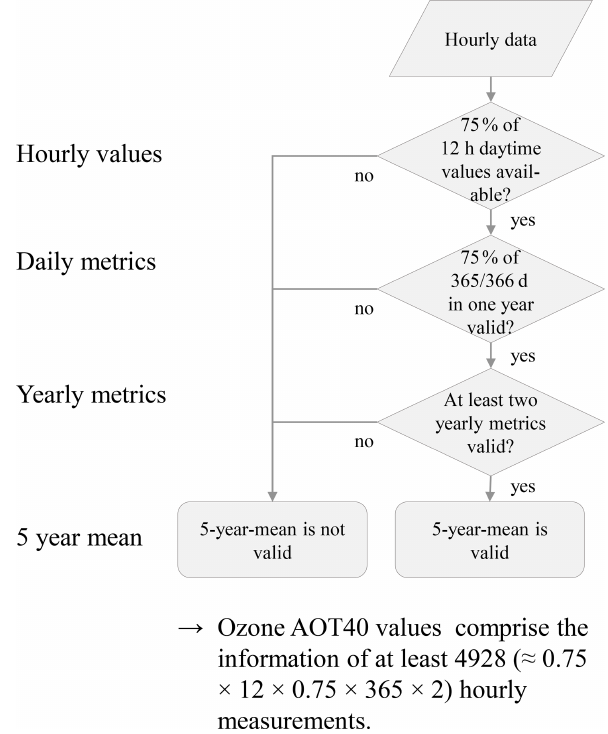
Figure B1. Data capture criteria for the AOT40 metric.